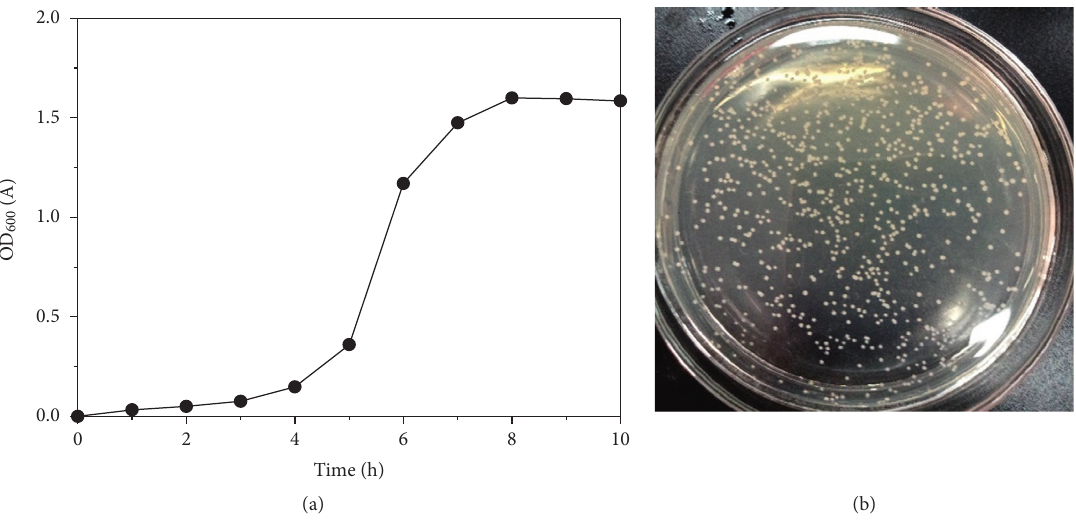
Figure 2: Typical (a) growth curve of E. coli and (b) image of E. coli in the LB medium.